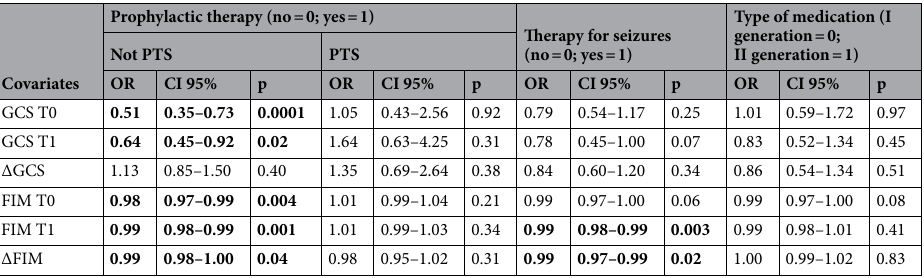
Table 5. Odds ratios (ORs) for the association between the use of anti-epileptic drugs and neurological/ rehabilitation outcome measured with the Glasgow Coma Scale (GCS) and the Functional Independence Measure (FIM). T0 on admission to neurorehabilitation, T1 at discharge. Significant difference are highlighted in bold.